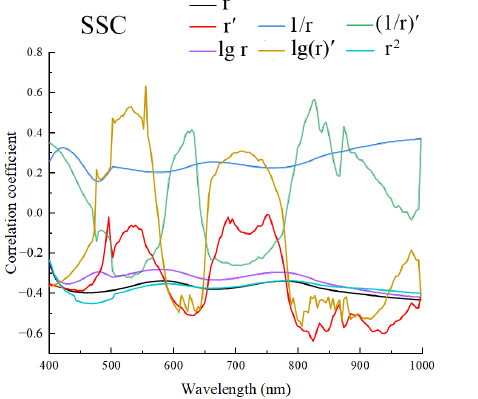
Figure 3. Correlation of original reflectance and S–G filter denoised reflectance for ( a ) SSC and ( b ) SOM.